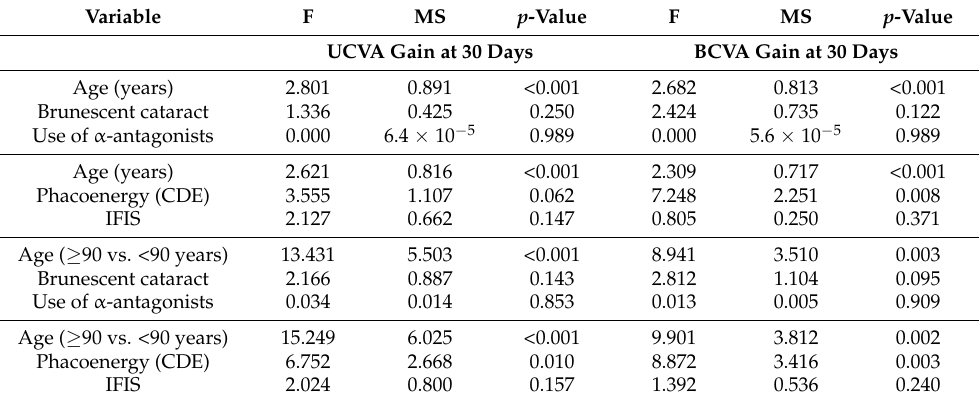
Table 5. One-way analysis of covariance (ANCOVA), including pre-and intraoperative